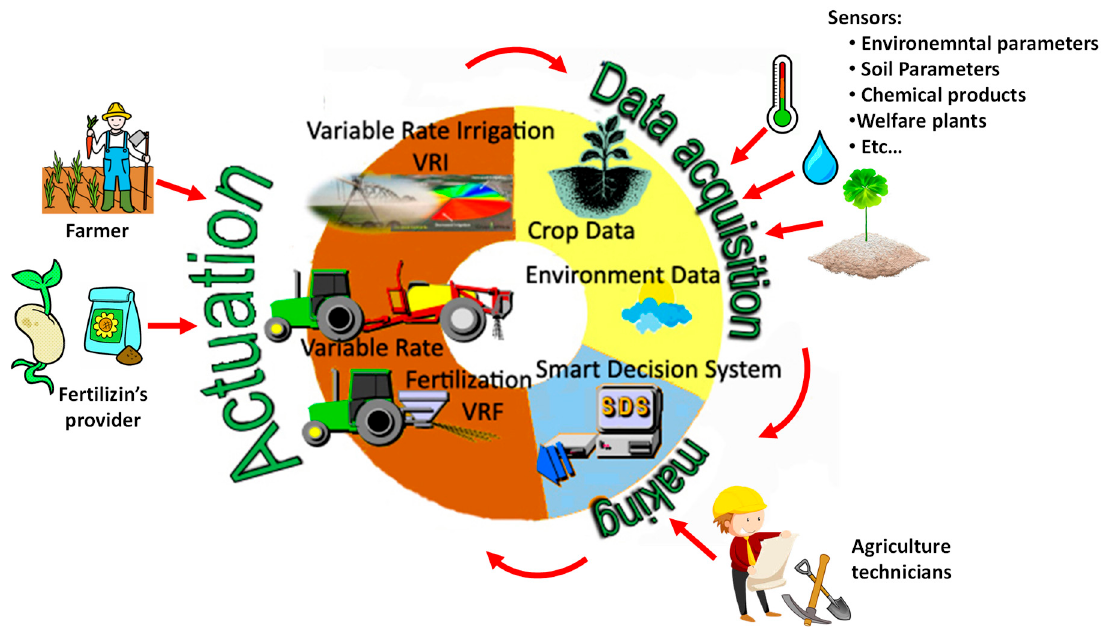
Figure 1. The cycle of smart farming data management.